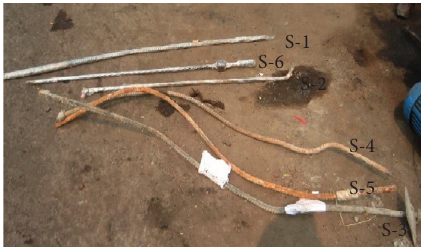
Figure 2: Bolt (cable) samples drilled from the underground coal